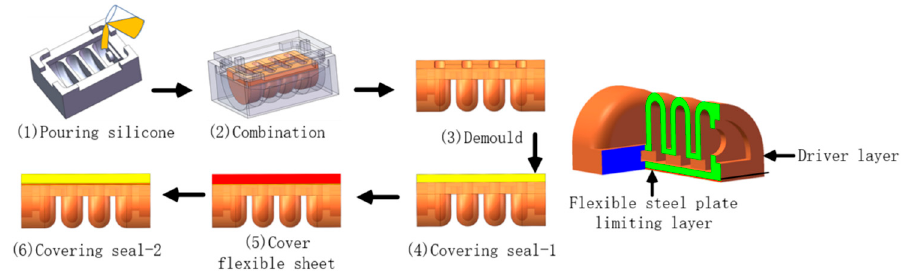
Figure 4. Soft driver production process.